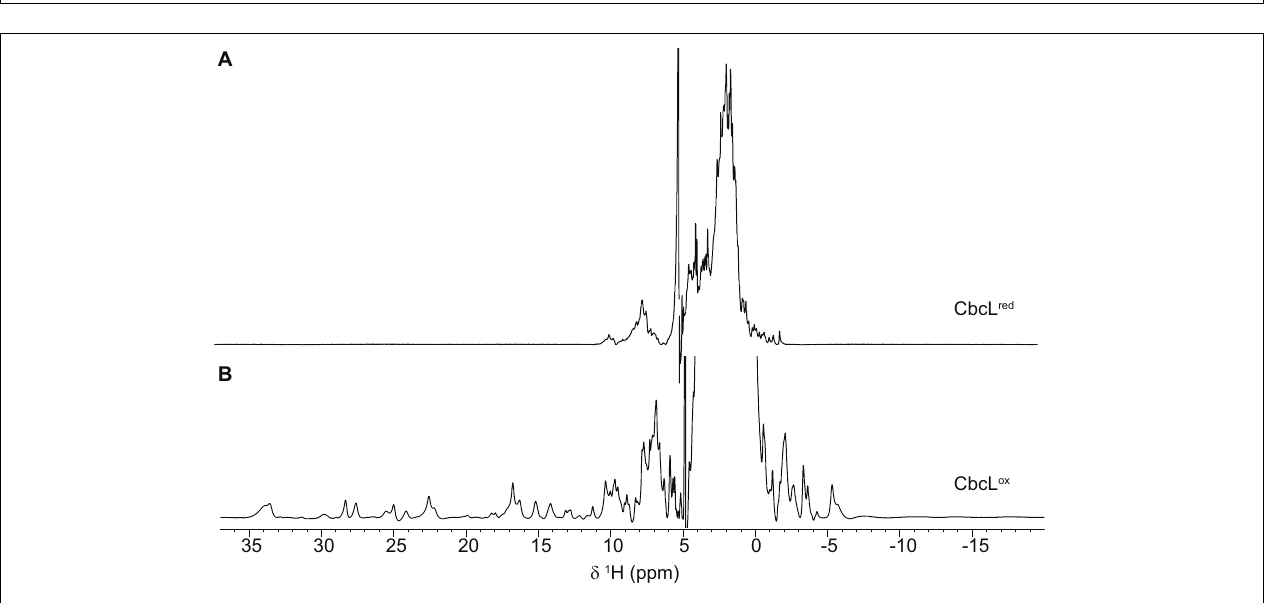
FIGURE 2 | 1D 1 H NMR spectra of cytochrome CbcL in the reduced (A) and oxidized (B) forms. The spectra were acquired at 25 ◦ C with 100 µ M of CbcL in 10 mM sodium phosphate pH 8.